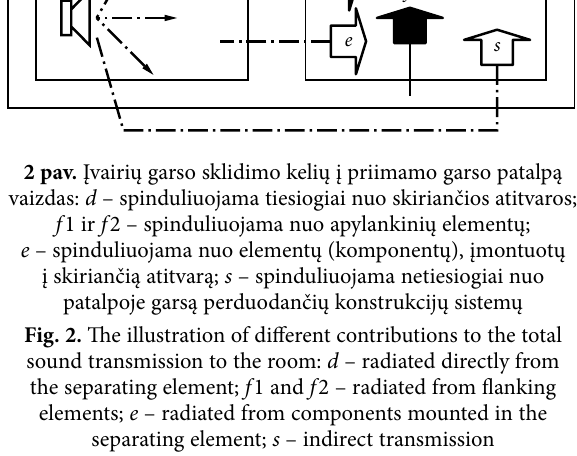
Fig. 2. The illustration of different contributions to the total sound transmission to the room: d – radiated directly from the separating element; f 1 and f 2 – radiated from flanking elements; e – radiated from components mounted in the separating element; s – indirect transmission